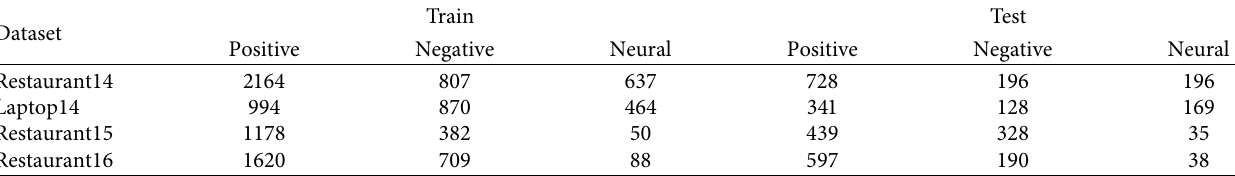
Table 2: Statistics of aspect-based sentiment analysis datasets.